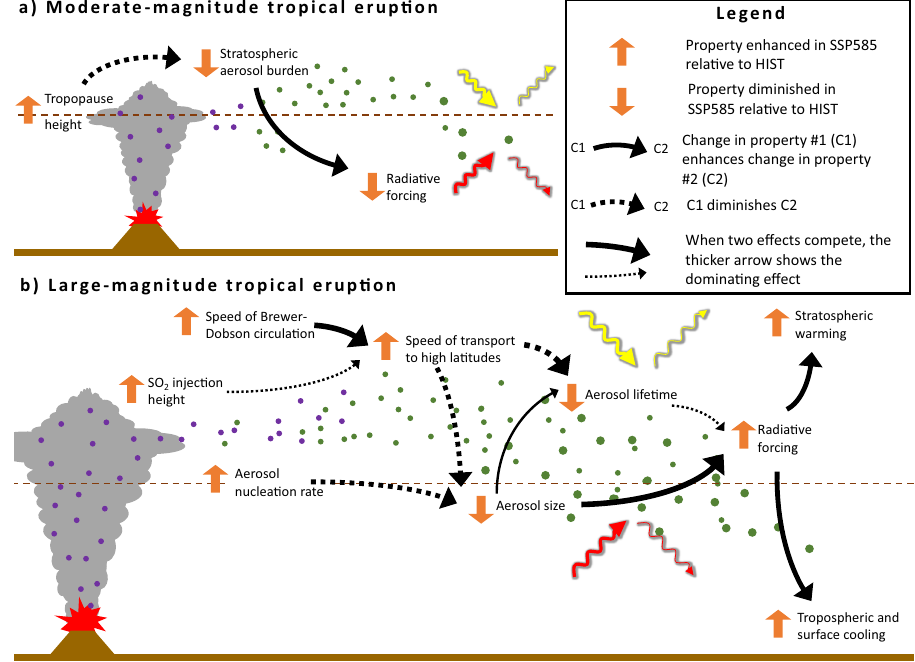
Fig. 9 Schematic summarizing how climate change affects volcanic forcing. Panel ( a ) refers to a moderate-magnitude tropical eruption and panel ( b ) refers to a large-magnitude tropical eruption.The symbols showing processes related to the volcanic sulfate aerosol cycle are identical to Fig. 1 (e.g., violet dots symbolize SO 2 , green dots symbolize sulfate aerosols). Symbols indicating how various properties are affected by climate changes or affect each other are de fi ned in the